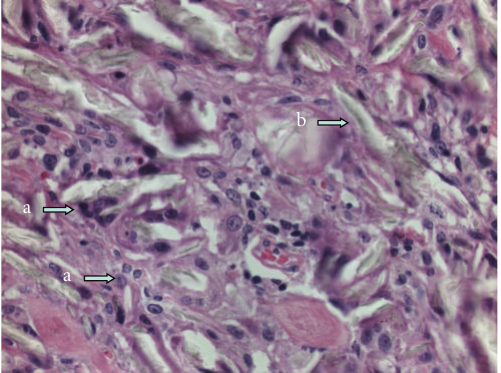
Figure 4: High-power view (H&E, × 400) of Figure 3, showing mul- tinucleated foreign-body giant cells (a) and crystals (b).